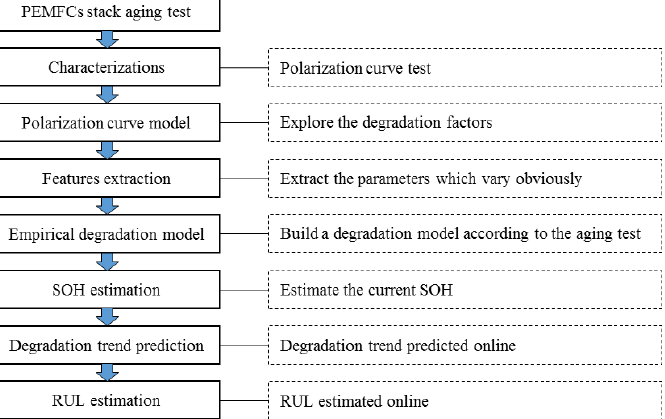
Figure 4. Model-based prognostics method for PEMFCs.